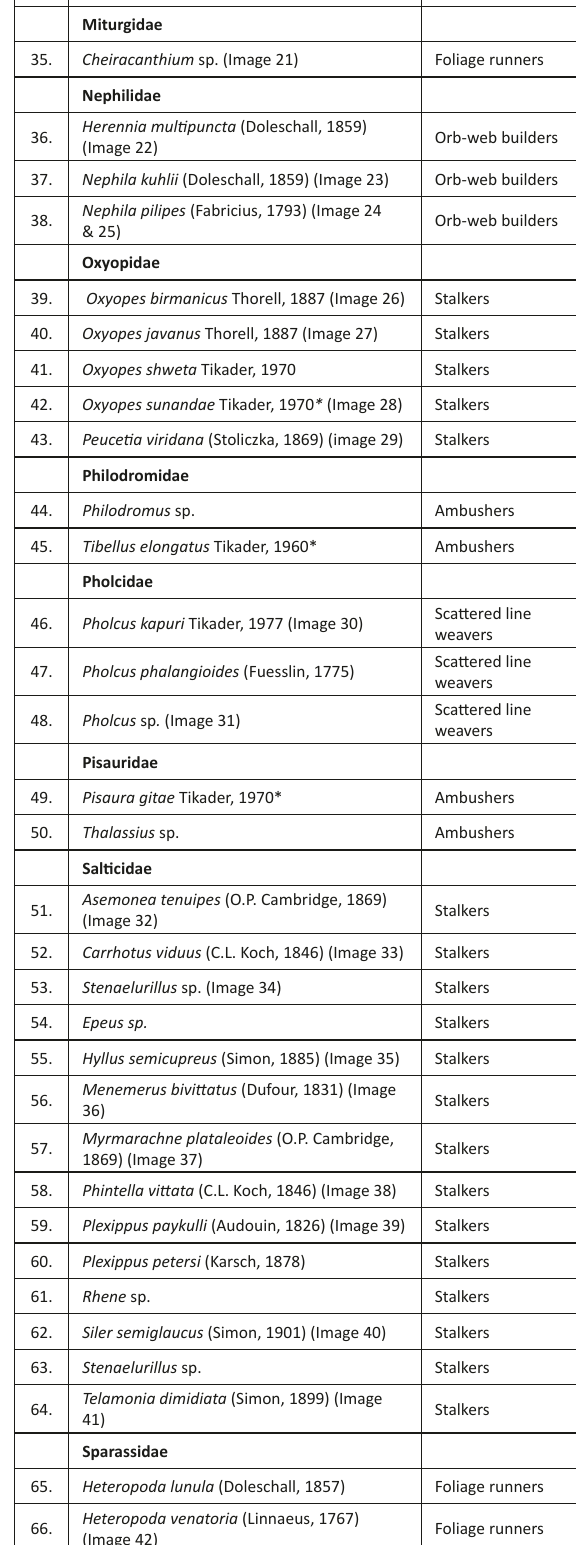
Table 1. Checklist of spiders identified in Kerala Agricultural University main